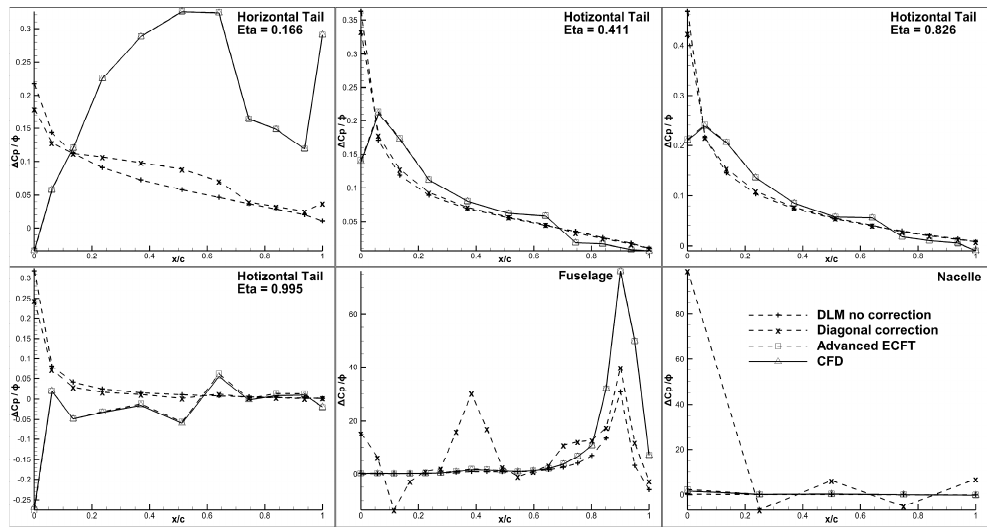
Figure 8. Rigid Δ Cp for a unit ϕ in the horizontal tail, fuselage, and nacelle component.